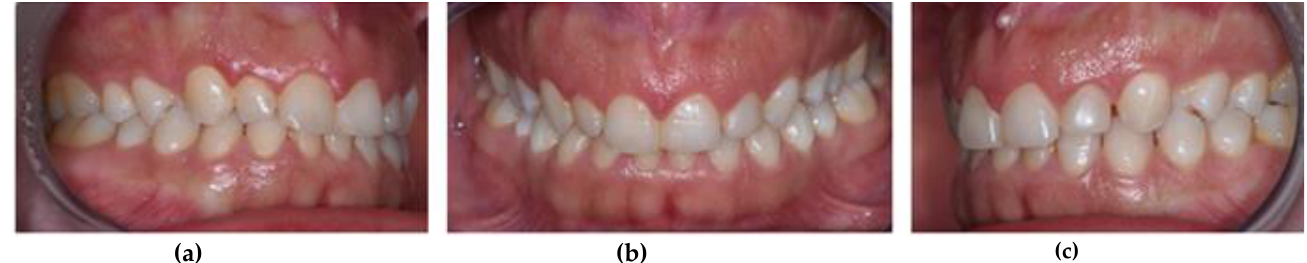
Figure 3. Intra-oral photographs of a participant from the control group (CG): ( a ) right view; ( b ) frontal view; ( c ) left view.